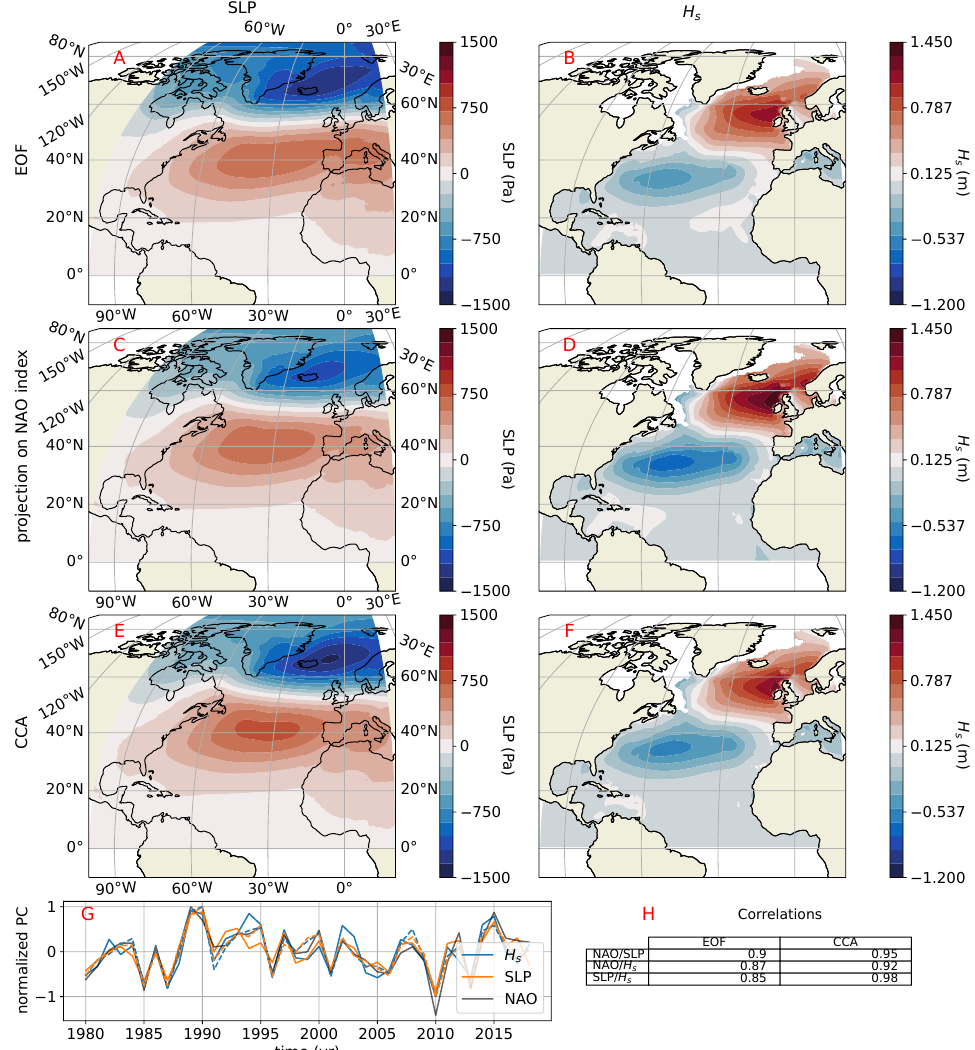
Figure 2. Leading EOF mode of JFM average SLP (panel ( A ), in Pa) and of JFM average H s (panel ( B ), in m) calculated with ERA-5 data for the period 1980–2018. Both EOFs are normalized with their respective PC maximum values. The explained variability of the first EOF of SLP and H s are respectively 57% and 41%. Projection of JFM average SLP (panel ( C )) and H s (panel ( D )) on the JFM average of NOAA NAO index. Leading CCA mode with the corresponding pattern for SLP (panel ( E )) and H s (panel ( F )). Panel ( G ): normalized PC of SLP (EOF: orange line, CCA dashed orange line) and H s (EOF: blue line, CCA, dashed blue). The optimized correlation of the H s and SLP CCA mode is 0.98. The JFM averaged NAO NOAA index is shown by a black line. Panel ( H ): table showing the correlation of the NOAA NAO index and the SLP PC (first row), H s PC (second row) and the correlation of the SLP and H s PC (third row) for the EOF analysis (first column) and the CCA analysis (second